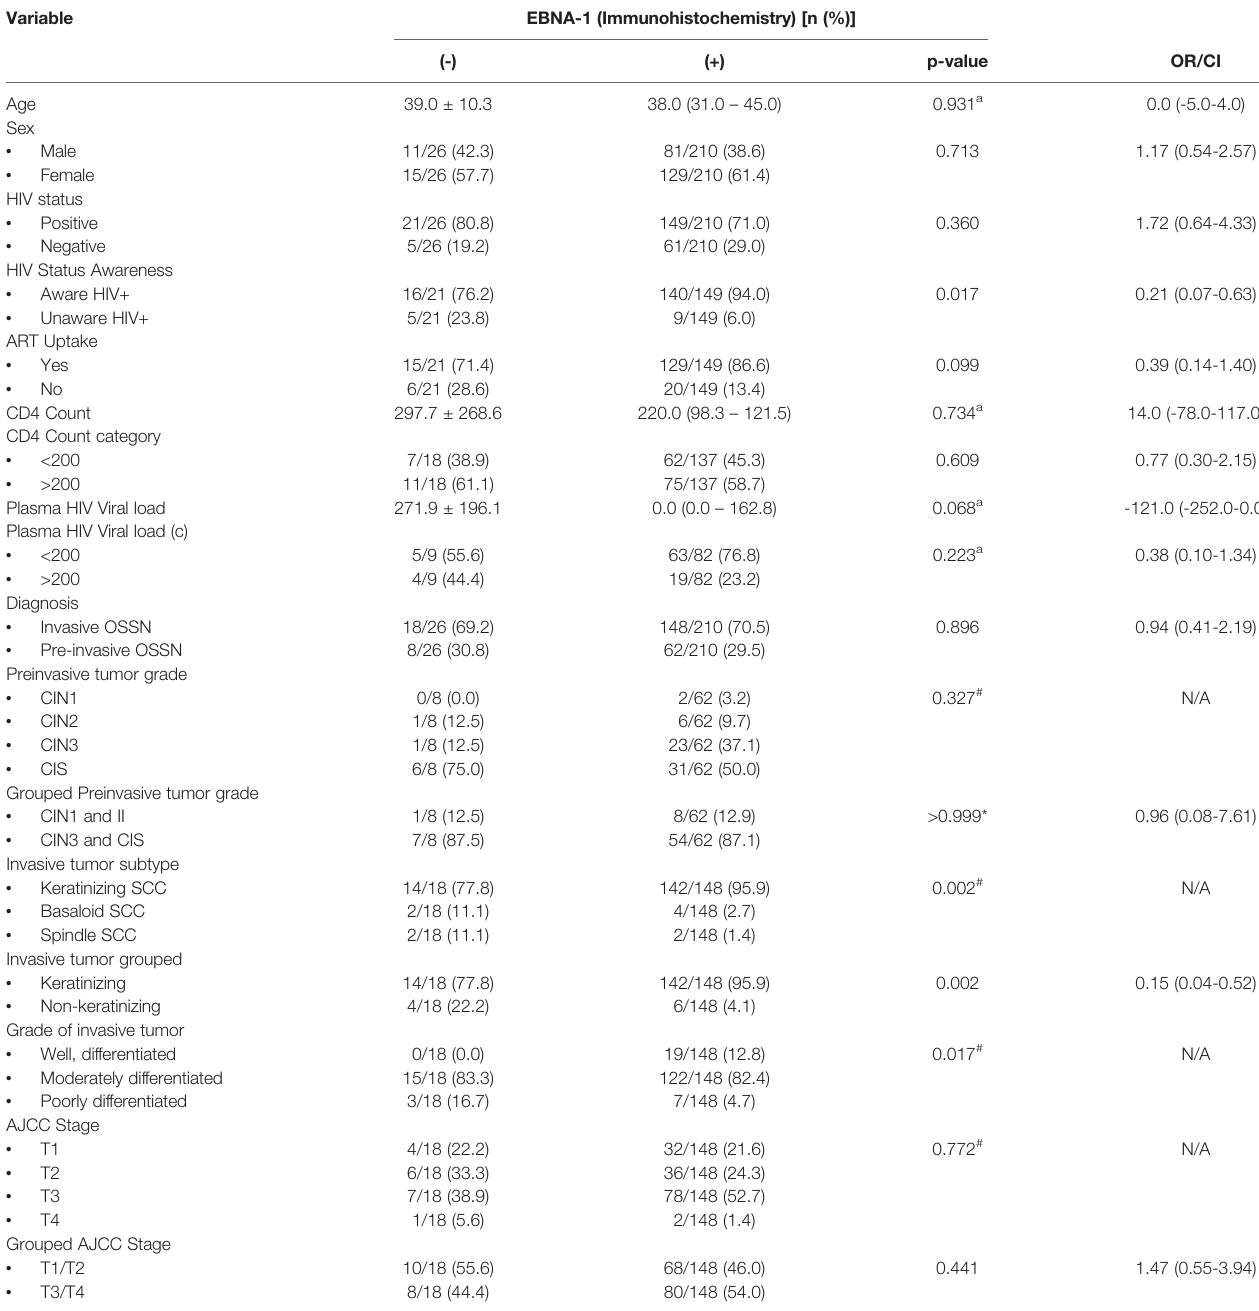
TABLE 3 | The relationship between immunohistochemistry expression of Epstein-Barr virus nuclear antigen 1 protein in formalin- fi xed paraf fi n-embedded tumor tissue with the patient clinicopathological variables.